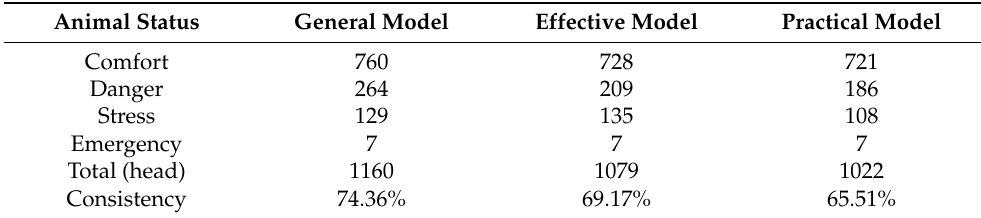
Table 8. Comparison of consistency between environmental and physiological index